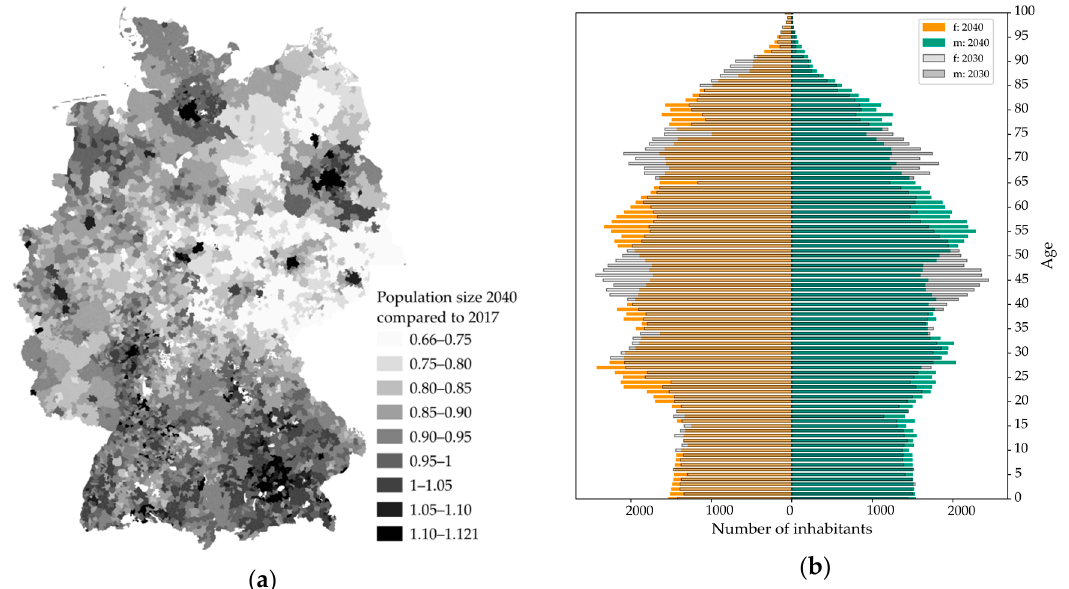
Figure 6. ( a ) Population projections for 2040 compared to 2017 per municipality. Map data copyright GeoBasis-DE / BKG (2020). ( b ) Population pyramid for Wiesbaden in 2030 [26] and 2040 (our own calculations).